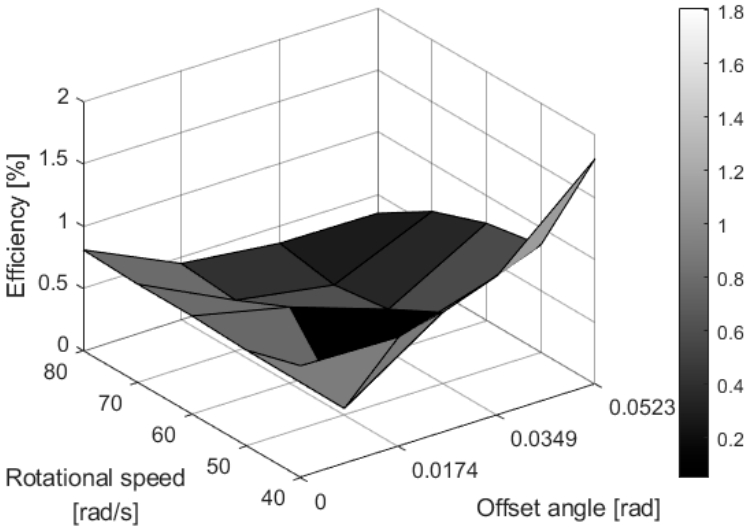
Figure 10. The di ff erence between theoretical and experimental Figure 10. The difference between theoretical and experimental results. Figure 10. The difference between theoretical and experimental results.